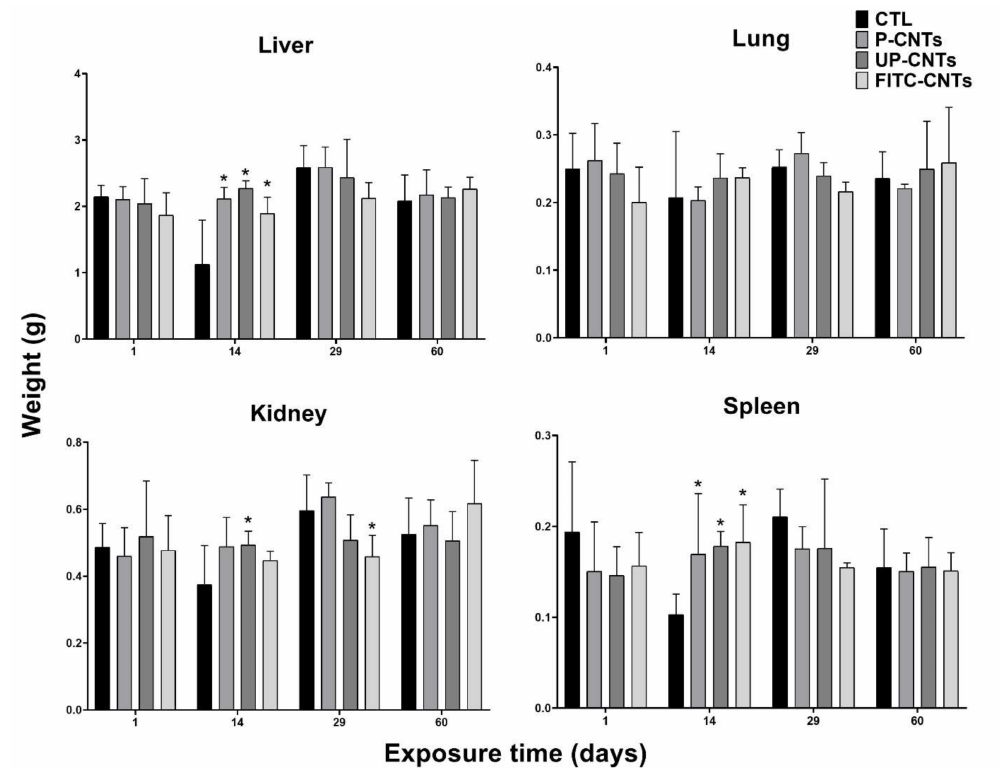
Figure 2. Organ weights (g) from mice exposed to di ff erent CNTs at di ff erent exposure times. Each graph shows the data of the indicated organ, the bars represent the mean ± SD obtained for each group ( n = 4). CTL, vehicle control (0.2% Pluronic F127 in sterile phosphate bu ff er). * indicates significant di ff erences vs the control group ( α = 0.05). Data were analyzed by Dunnett’s